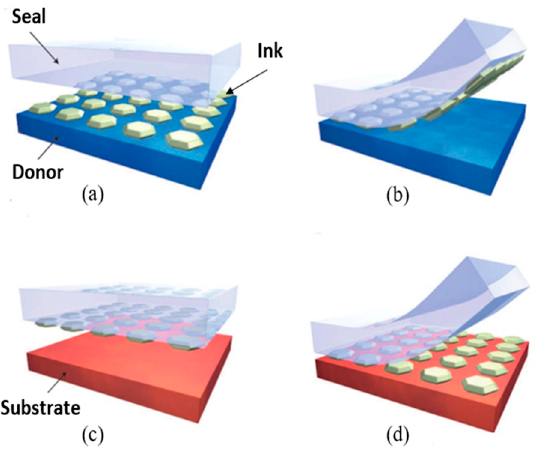
Figure 2. Microtransfer printing assembly process diagram (reproduced from [48]).